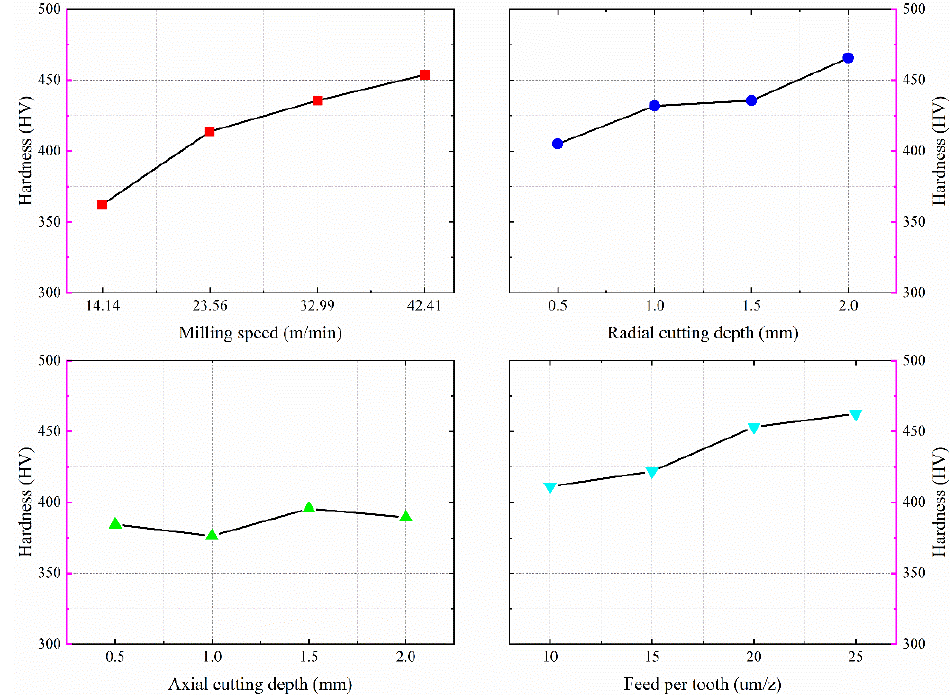
Figure 20. The effect of milling parameters on surface microhardness.